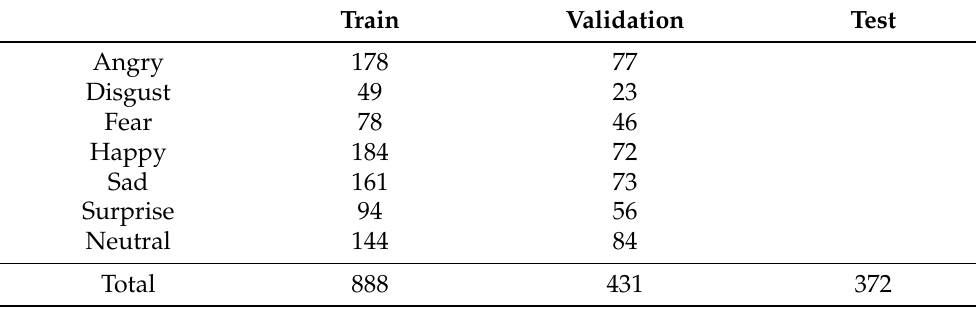
Table 4. SFEW aligned face samples per class. The test set contains 372 unlabeled images.